Question: Condense the content of this figure into a single sentence.
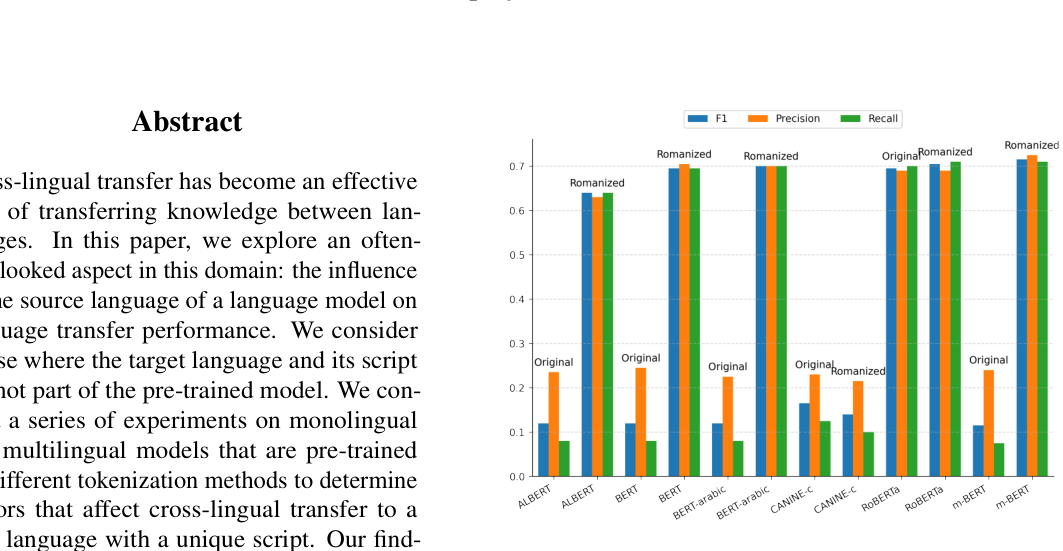
Answer: We analyze the effect of script and tokenizer on cross-lingual transfer on a target language with a new script. We select six monolingual and multilingual mod- els pre-trained using sub-word tokenizers and character tokenizers. We fine-tune these models on the NER and POS tasks in the original script (FIDEL) and the roman- ized version (Latin). We observe that RoBERTa has bet- ter cross-lingual transfer in both the original script and the romanized version. We also find that romanization is strongly beneficial in all cases of subword-based models (ALBERT, BERT,m-BERT). Additionally, fine-tuning Arabic-BERT, which is typologically similar to our tar- get language (Amharic), provides no advantage. We employ the base version of the models across all cases to ensure a fair comparison. The reported F1-score is averaged over five runs, with a standard deviation rang- ing between -0.003 and 0.009.